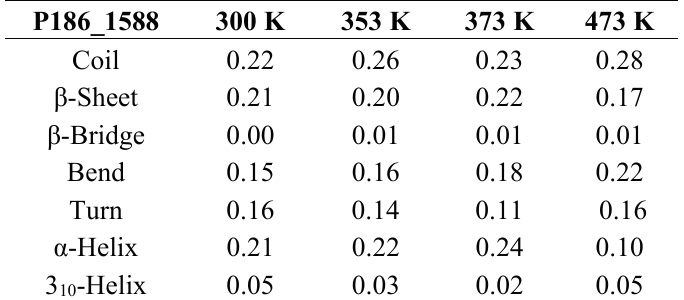
Table 5. Average second structure contents in P186_1588 trajectories obtained at different